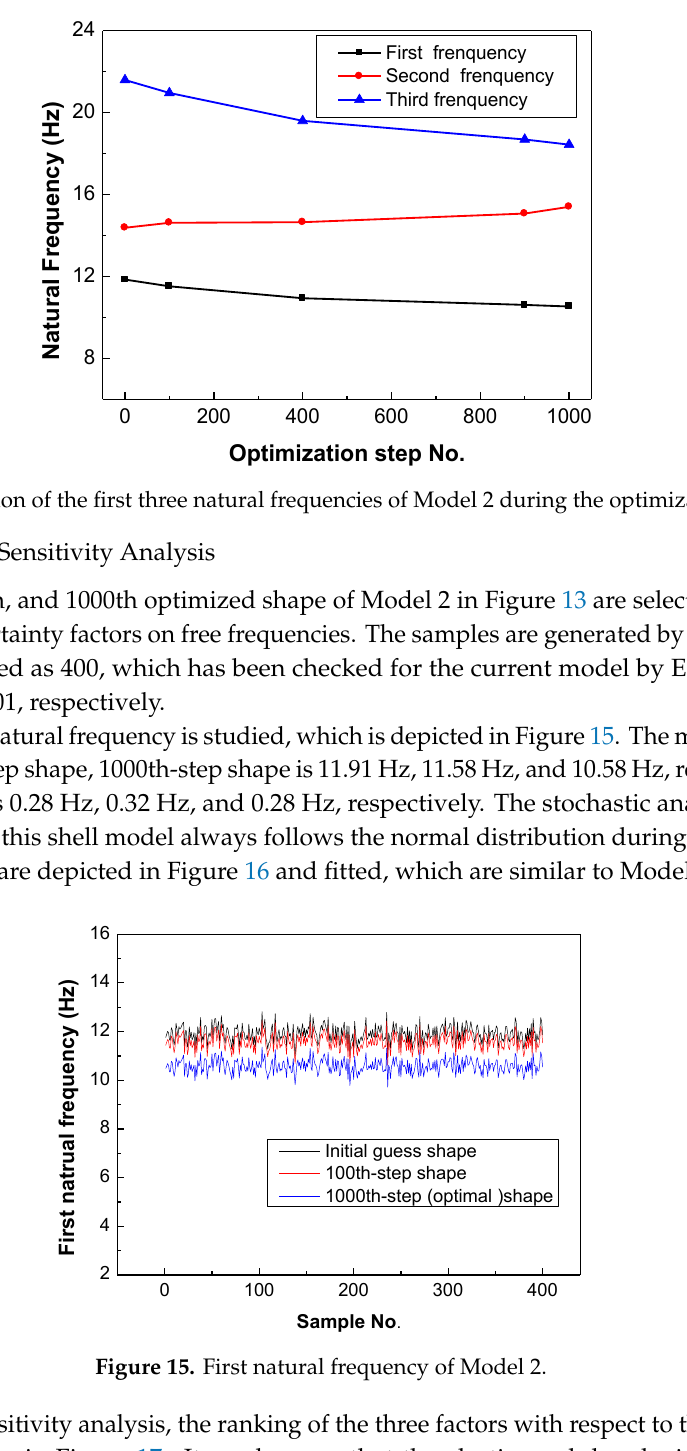
Figure 13. Shape variation of Model 2 during the optimization process: ( a ) Initial guess; ( b ) 100th step; and, ( c ) 1000th step (optimal).